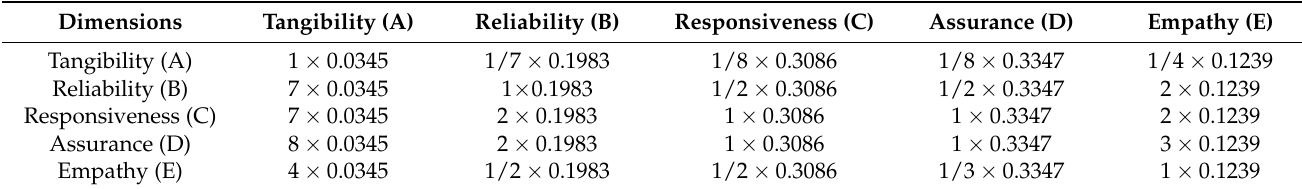
Table 7. Normalised matrix calculation.